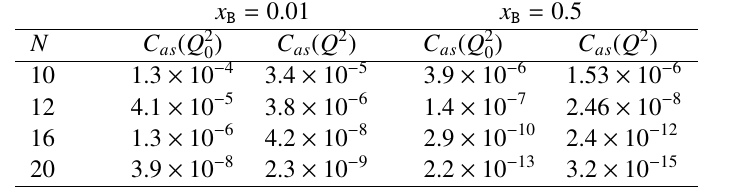
Table 1. The relative accuracy ε ( N ) of numerical evaluation of the MB integral (18) for di ff erent values of terms N in the sum (16) x B = 0 .